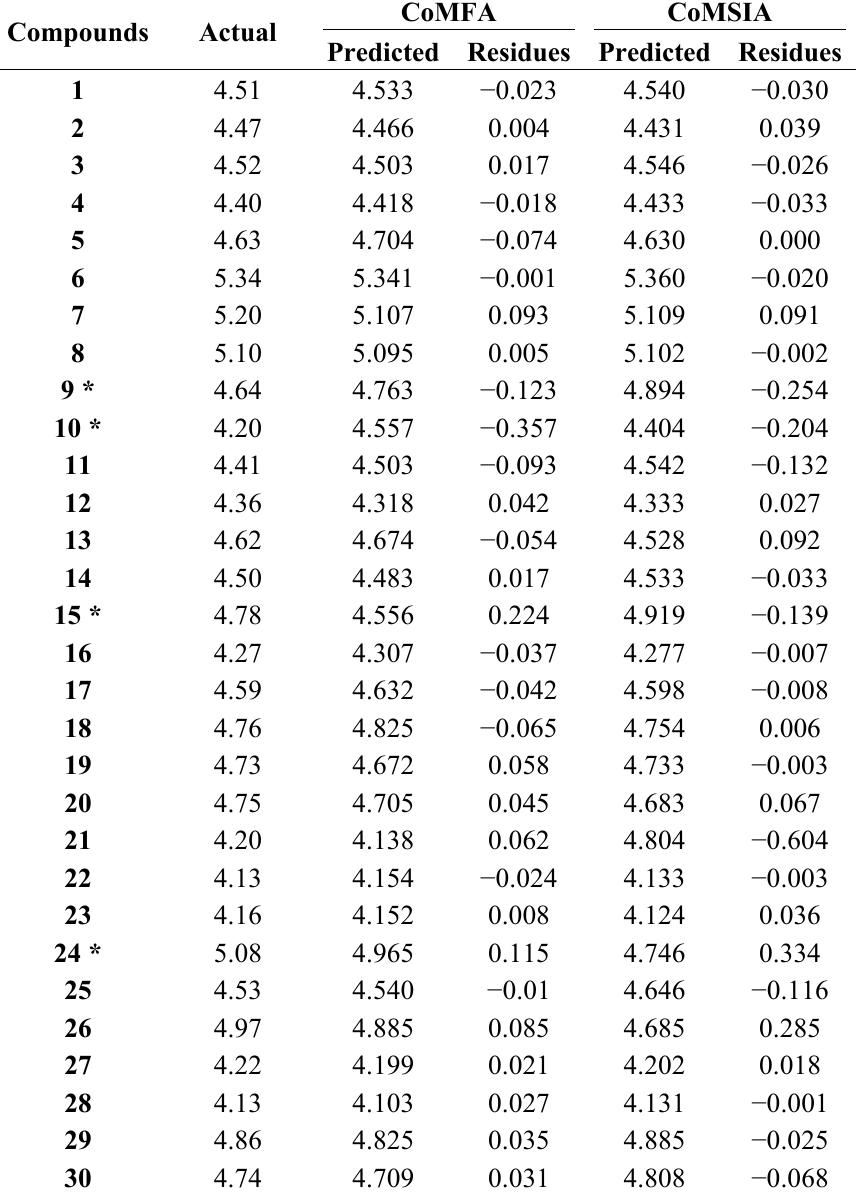
) of compounds. * Test 50